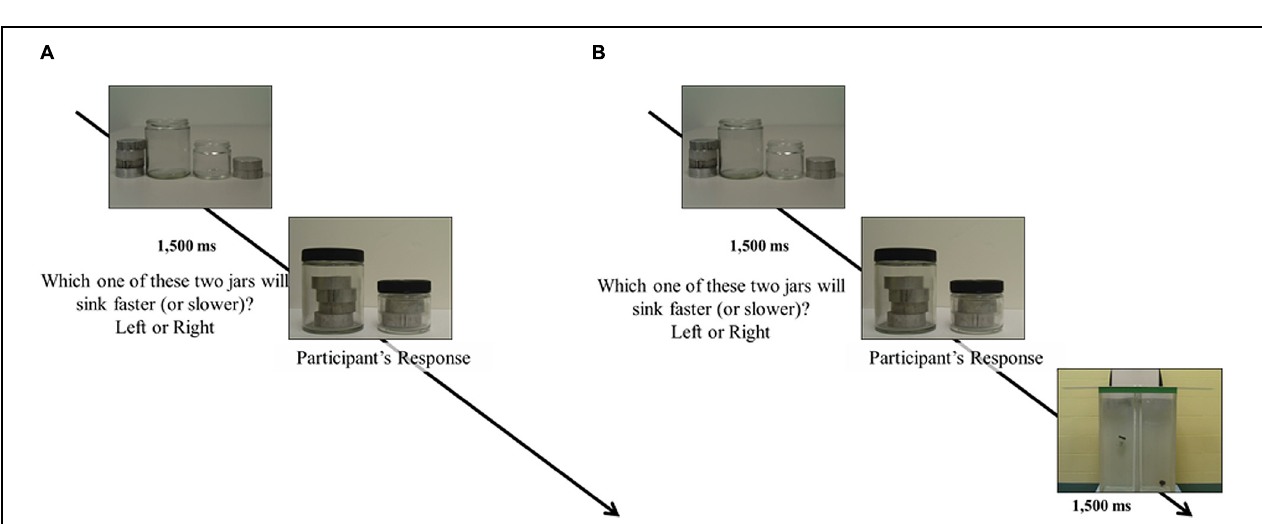
FIGURE 4 | Schematic representation of prediction trials. (A) Prediction trial without feedback. (B) With feedback (a picture is shown of the objects after being dropped in a tank of